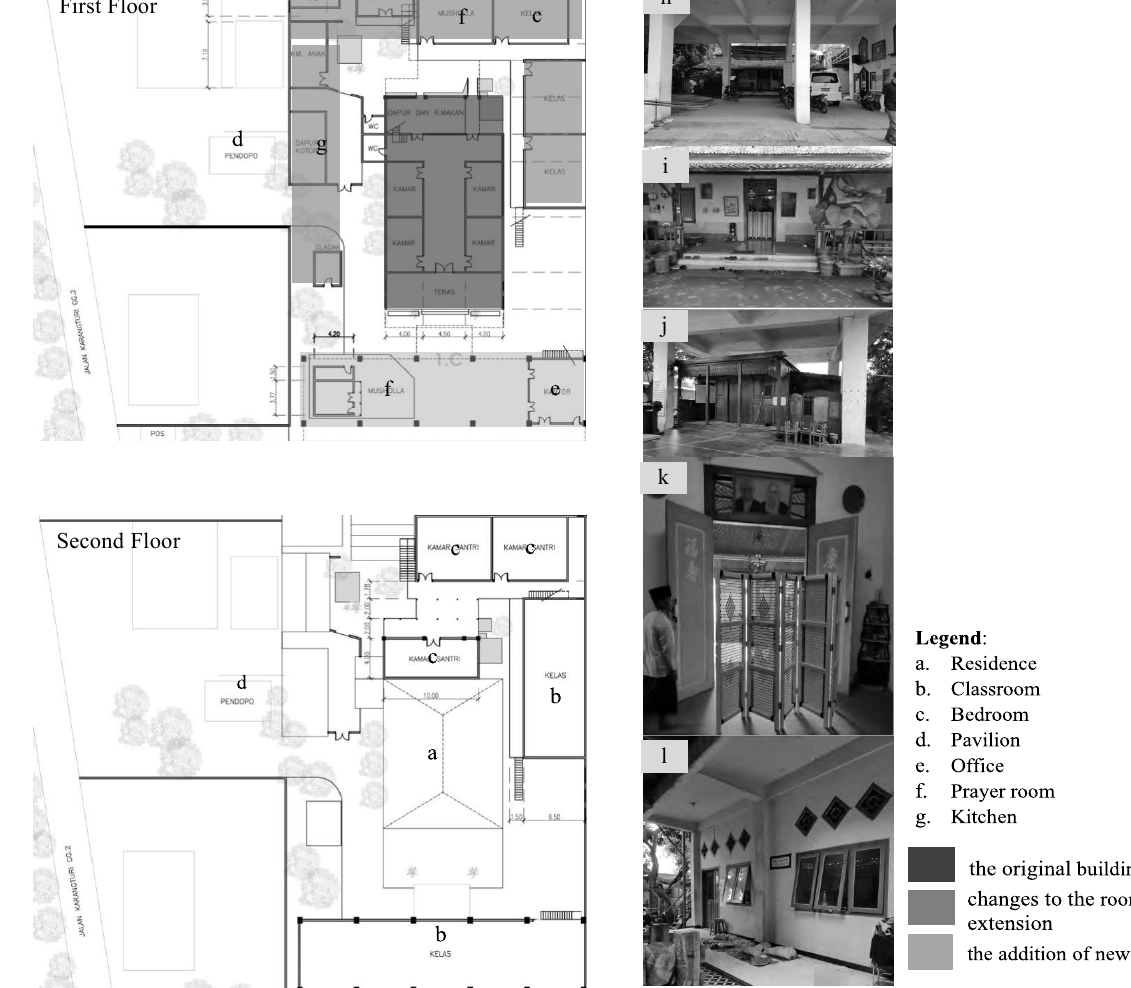
Figure 11. The first and second floor showing the transformation of the building for schools, (h) the entrance through the first floor of the new building, (i) the terrace of the main building, (j) a prayer room on the first floor of the new building, (k) the lobby of the